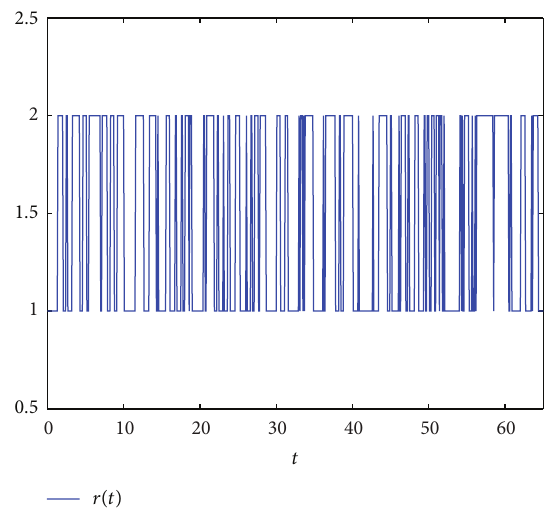
Figure 1: Markovian chain generated by probability transition matrix corresponding to the generator (50) with Δ𝑡 = 0.01, 𝛾 (0) = 2.